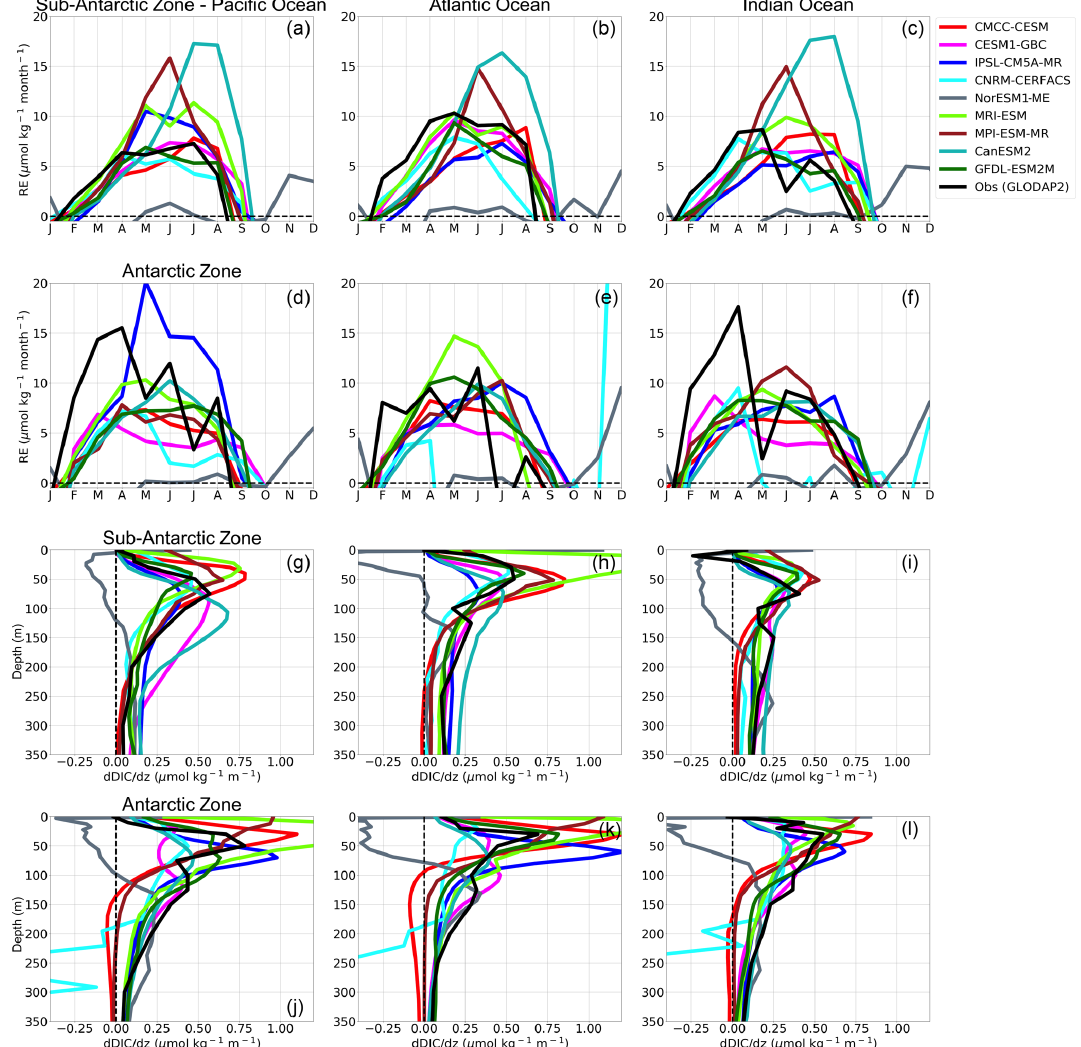
Figure 10. (a–f) Estimated DIC entrainment fluxes (molkgmonth − 1 ) at the base of the mixed layer and (g–i) vertical DIC gradients (µmolkg − 1 m − 1 ) in the Sub-Antarctic and Antarctic zones of the Pacific Ocean (first column), Atlantic Ocean (second column) and In- dian Ocean (third